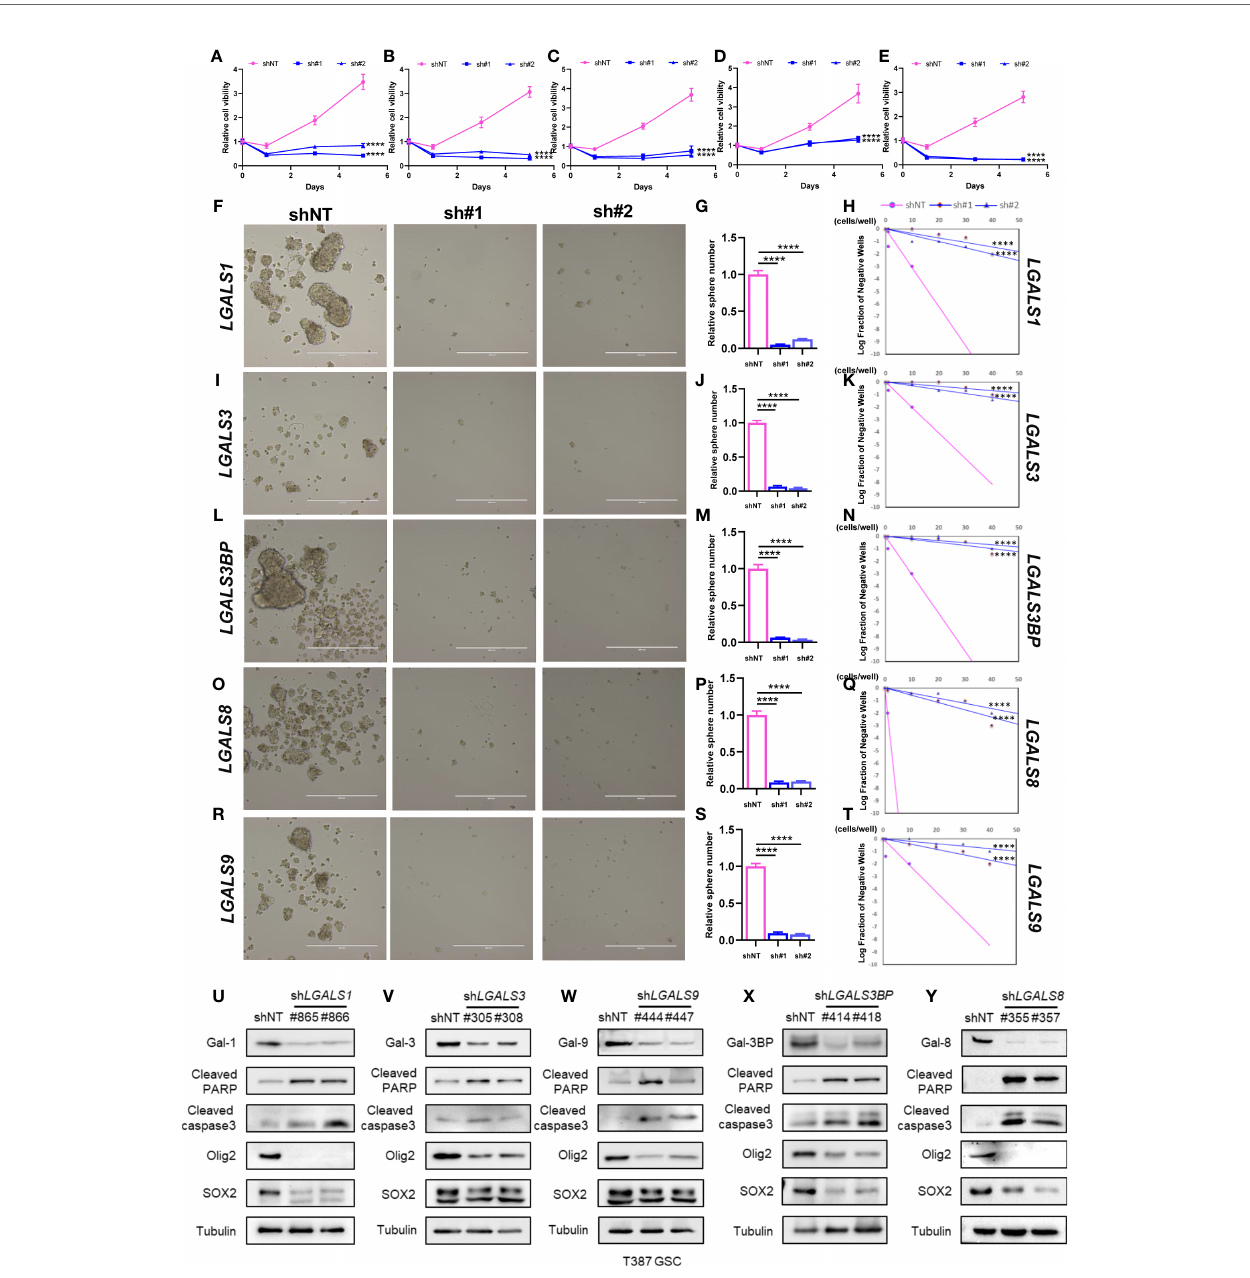
FIGURE 8 | Galectins promote GSC stemness maintenance and proliferation in vitro . (A – E) The cell viability assay of T387 GSC under LGALS1 (A) , LGALS3 (B) , LGALS3BP (C) , LGALS8 (D) , and LGALS9 (E) knockdown. (F – T) Sphere formation assay and in vitro limiting dilution assay of GSC under LGALSs knockdown. T387 GSC was transduced with two different shRNA sequences against LGALS1 (F) , LGALS3 (I) , LGALS3BP (L) , LGALS8 (O) , and LGALS9 (R) and incubated for 5 days, then tumorspheres were assessed by bright- fi eld microscopy. Relative quanti fi cation of tumorspheres in T387 GSC after LGALS s knockdown is shown in panels (G, J, M, P, S) . In vitro limiting dilution assays were performed in T387 GSC expressed shNT and sh LGALS1 (H) , sh LGALS3 (K) , sh LGALS3BP (N) , sh LGALS8 (Q) , and sh LGALS9 (T) . (U – Y) Western blotting analysis of cleaved PARP, cleaved caspase3, Oligo2, and SOX2 proteins in T387 GSC with LGALS1 (U) , LGALS3 (V) , LGALS3BP (W) , LGALS8 (X) , and LGALS9 (Y) knockdown. GSC, glioma stem cell